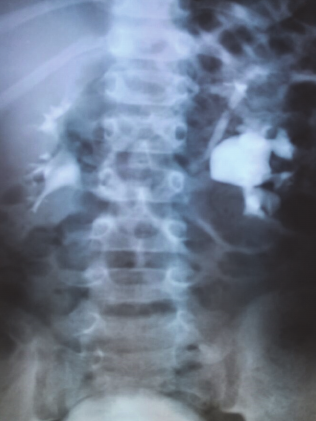
Figure 1: The intravenous urography shows the dilated left lower moiety with an abrupt transition to nondilated ureter at the pelvi- ureteric junction consistent with pelviureteric junction obstruction of the lower moiety. The upper moiety is